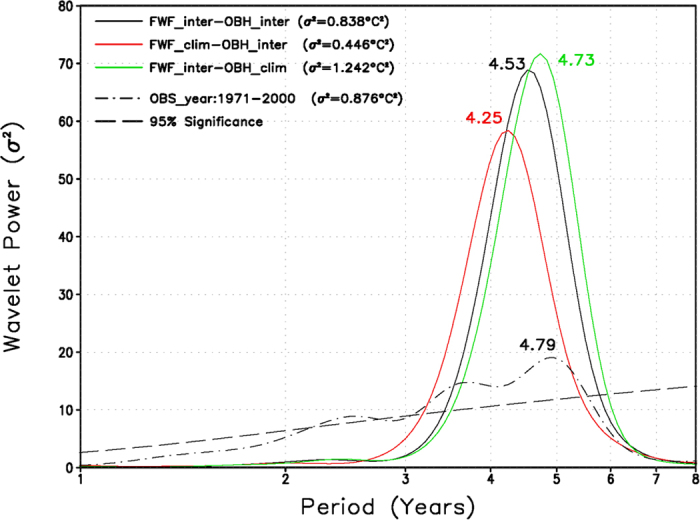
Wavelet power spectra for Niño3.4 SST anomalies calculated in FWFinter-OBHinter, FWFclim-OBHinter, and FWFinter-OBHclim.The observed SST data used for the corresponding calculation are from Smith et al. (2008). The dot-dashed line is the 95% significance level for these runs, assuming a white noise process.